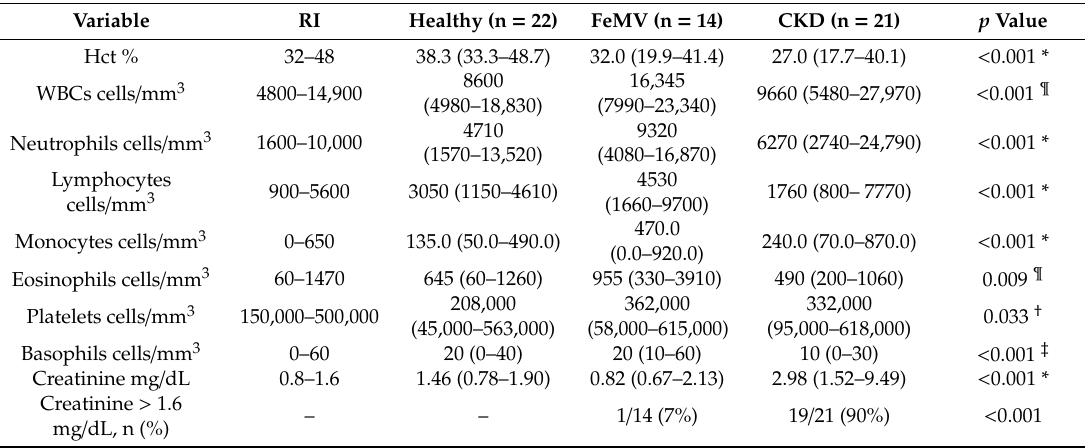
Table 2. Complete blood count and serum chemistry values of cats belonging to the three study groups: Healthy (n = 22), FeMV (n = 14) and CKD (n =